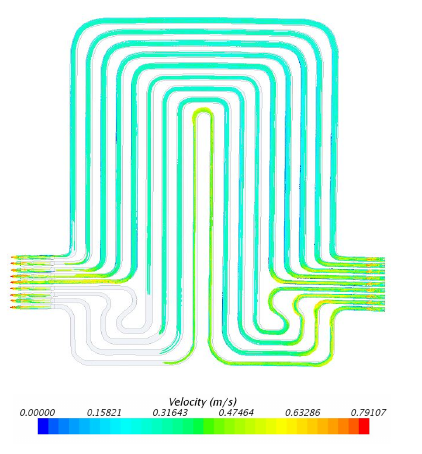
Figure 15. Velocity profile at 60 A with 5 °C, 15 °C, 25 °C, and 35 °C.